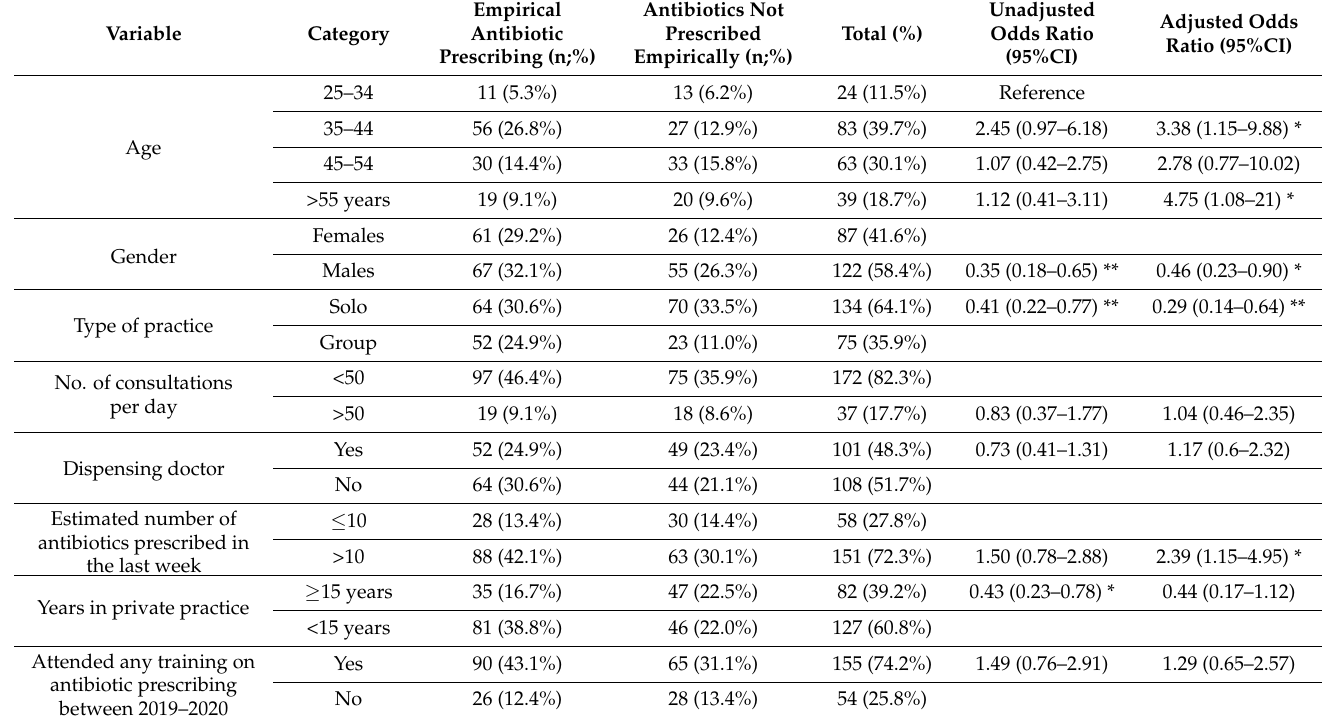
Table 3. Demographic factors associated with empiric antibiotic prescribing.